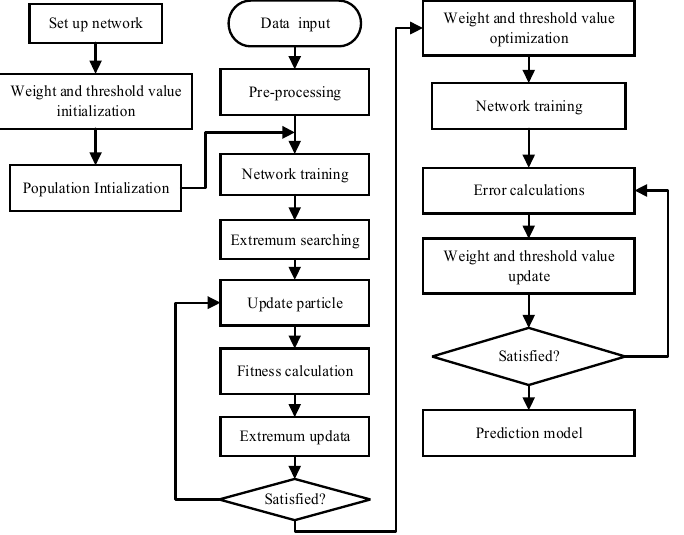
Figure 17. The calculation procedure of particle swarm optimization back propagation (PSO-BP) method.